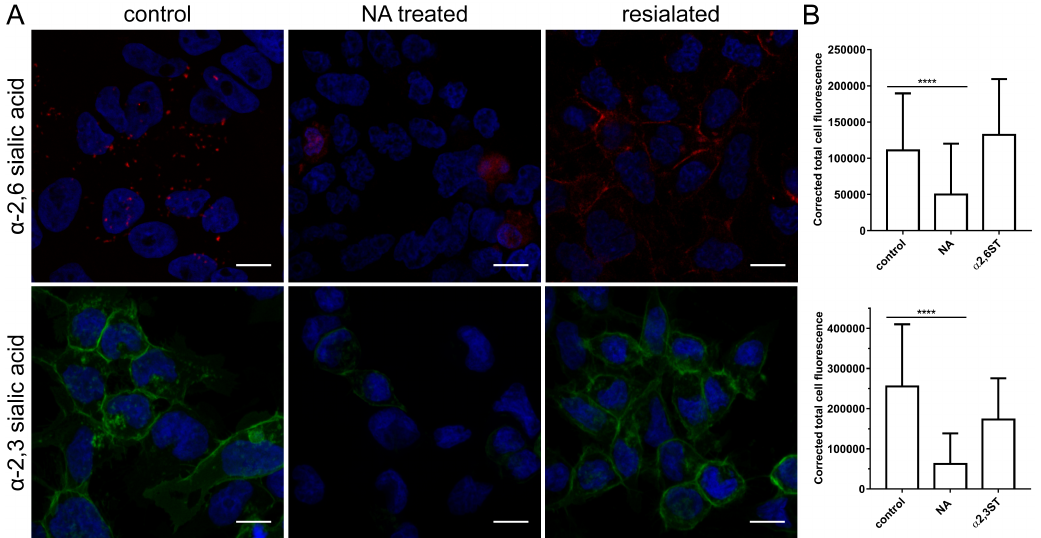
Figure 6. Activity of neuraminidase and sialyltransferases. ( A ) HRT-18G cells were treated with type II neuraminidase (NA, 500 mU/mL) and overlaid with α -2,3-sialyltransferase ( α 2,3-ST) or α -2,6-sialyltransferase ( α 2,6-ST) in the presence of 1 mM cytidine-5 (cid:48) -monophospho- N -acetylneuraminic acid for 2 h at 37 ◦ C. Following treatment, cells were fixed, and SAs were visualized with sambucus nigra lectin ( α -2,3-SAs specific) labelled with fluorescein (in green) or maackia amurensis lectin ( α -2,6-SAs specific) labelled with Cy3 (in red). Scale bar 10 µ m. Data were collected from a minimum of 12 fields of view, from at least three different samples. ( B ) Graphs present corrected total cell fluorescence calculated by subtracting the product of multiplying the cell surface and the mean background fluorescence from total cell fluorescence. The data is presented as mean ± SD from at least one hundred cells per condition. (* p < 0.05; ** p < 0.01; *** p < 0.001; **** p <